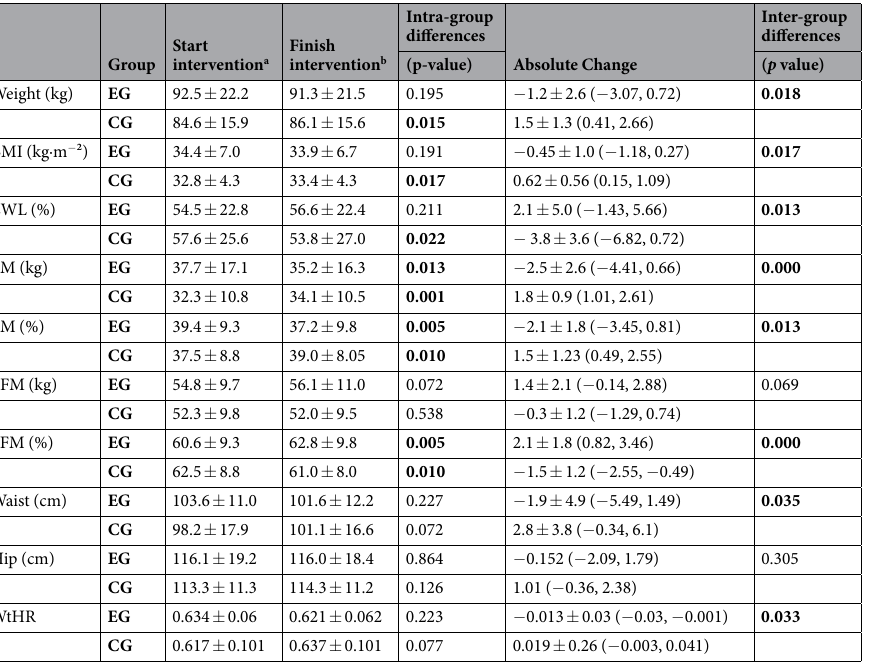
Table 2. Changes in body composition and anthropometric data after exercise program. Data are mean ± SD. 95% confidence intervals in brackets. BMI, body mass index; EWL, excess weight loss; FM, fat mass; FFM, fat free mass; WtHR, waist-to-height ratio; EG, exercise group; CG, control group. Note: a 37 months after surgery; b 42 months after